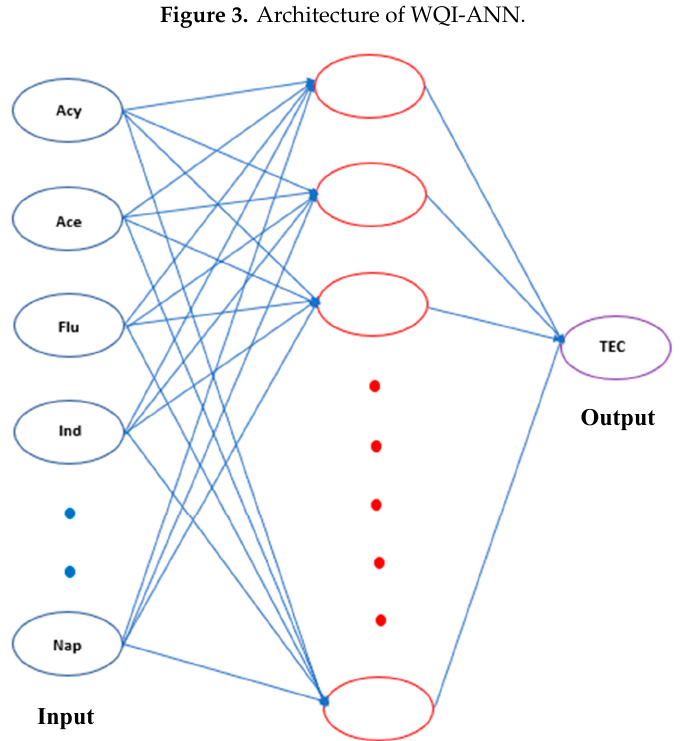
Figure 4. Architecture of Figure 4 . Architecture of TEC-ANN.